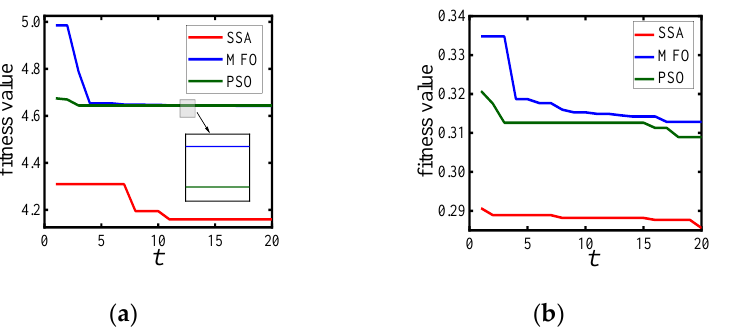
Figure 7. Flow chart of the controller parameters optimized using SSA.